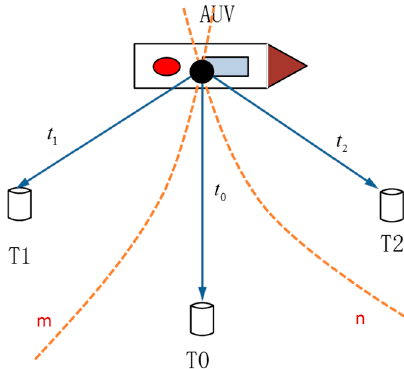
Figure 2. Schematic diagram of the TDOA positioning model.